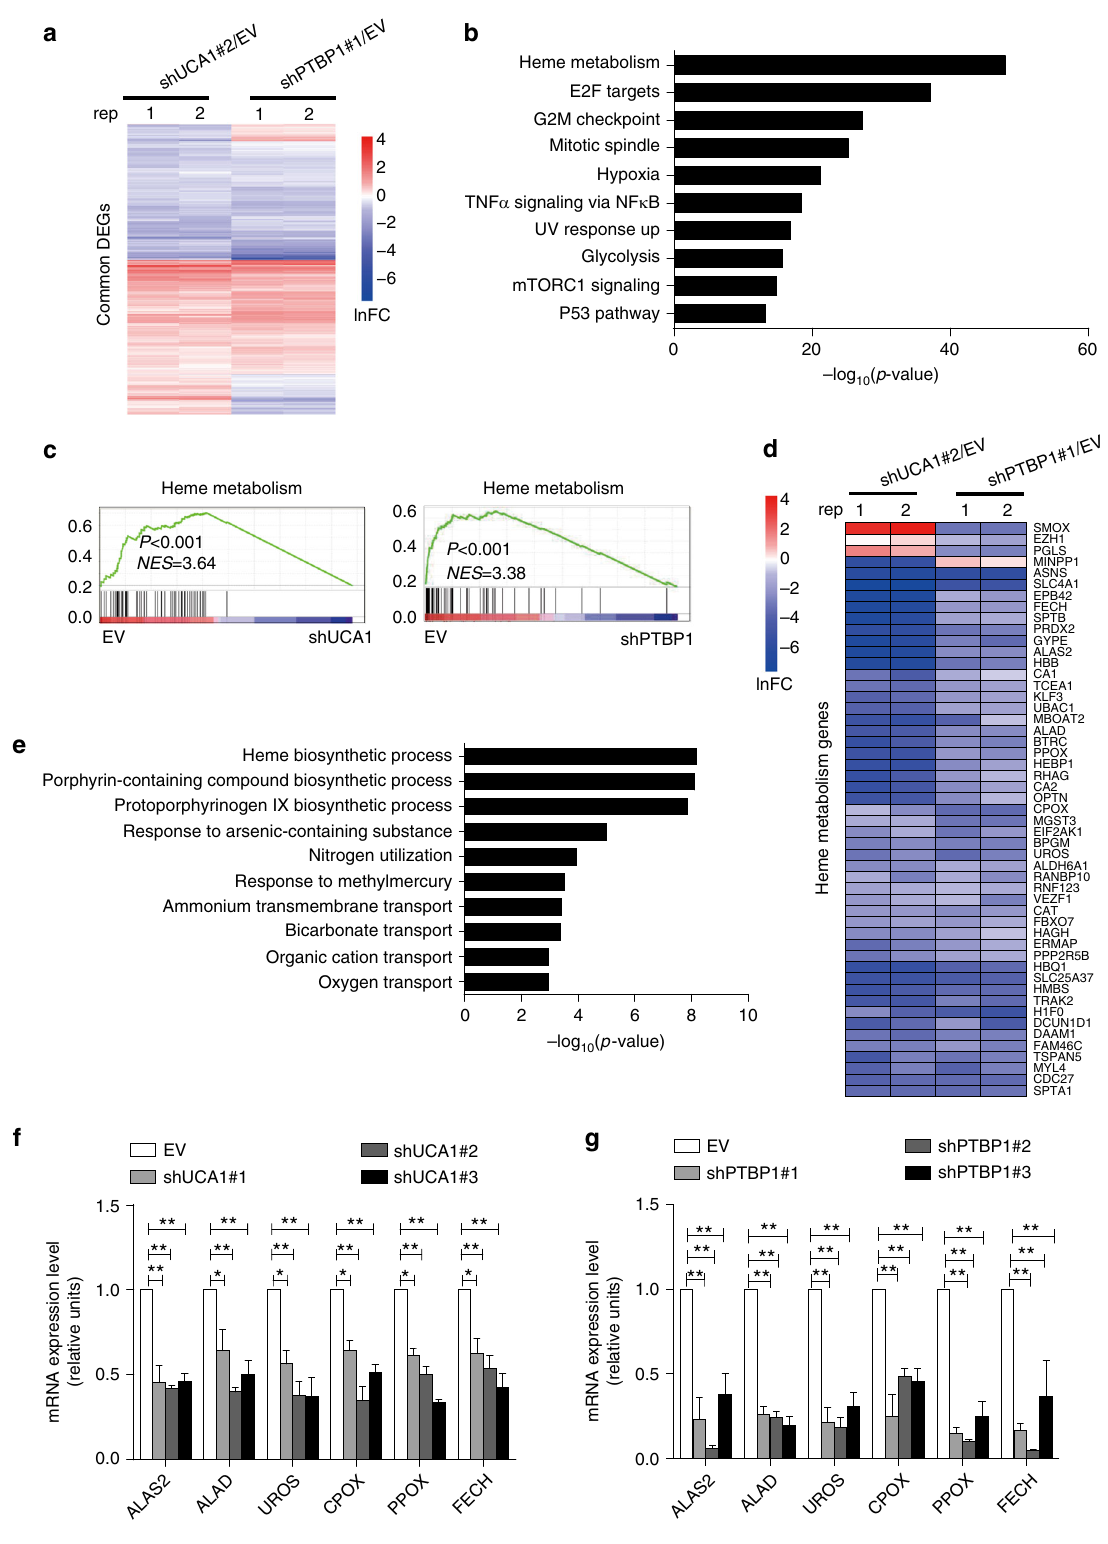
Fig. 4 Linking UCA1 and PTBP1-regulated erythroid maturation to the control of heme biosynthesis. a The heatmap depicts the fold-change in DEGs after UCA1 (shRNA#2/EV) or PTBP1 depletion (shRNA#1/EV) in differentiated erythroblasts at day 8. b Hallmark enrichment analysis of the common DEGs. c GSEA showed heme metabolism gene set enrichment from the common DEGs after UCA1 (left) or PTBP1 (right) depletion. Normalized enrichment scores (NES) and P -values are indicated in each plot. d Heatmap shows the expression of heme metabolism related genes after UCA1 or PTBP1 downregulation. e GO analysis of the common heme metabolism related genes after UCA1 or PTBP1 depletion. f , g qRT-PCR to analyze the expression of genes involved in heme biosynthesis on days 8 in differentiated primary erythroid cells after UCA1 ( f ) or PTBP1 ( g ) depletion. GAPDH mRNA was used as an internal control. Bar graphs were generated with data from three independent experiments ( n = 3). Error bars represent SEM. P -values were determined by Student ’ s t -test. *P< 0.05, **P<